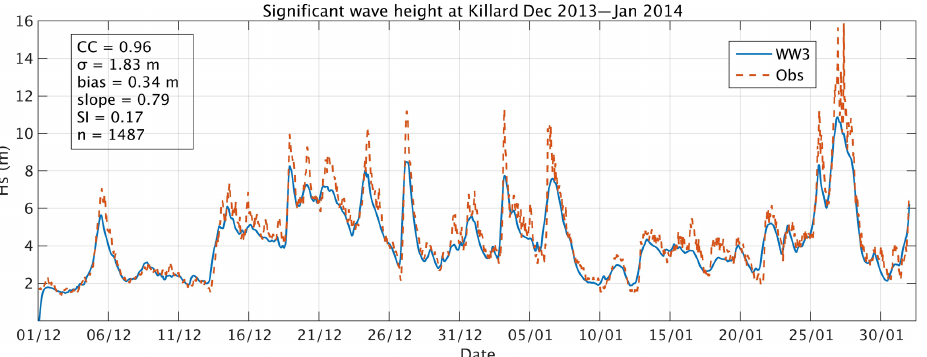
Figure 3. Timeseries of significant wave height for December 2013 and January 2014 comparing observations from the Killard (52.774, − 9.587) buoy and modelled values. In the upper left corner we provided the following statistical parameters: Correlation coefficient (CC), standard deviation ( σ ), bias, slope, scatter index (SI), and the number of records ( n